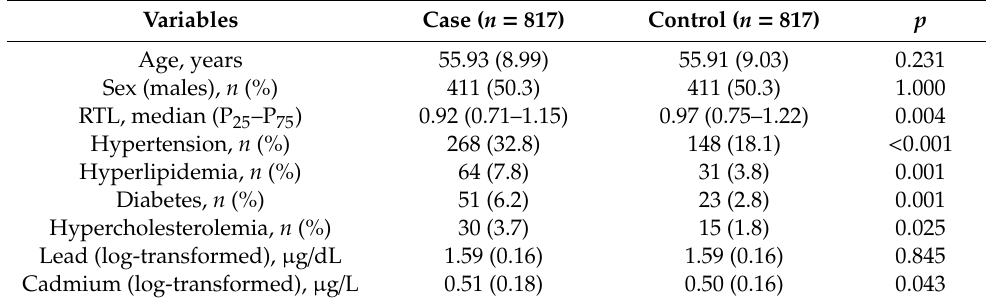
Table 1. Sociodemographic Characteristics between Hearing Loss Cases and